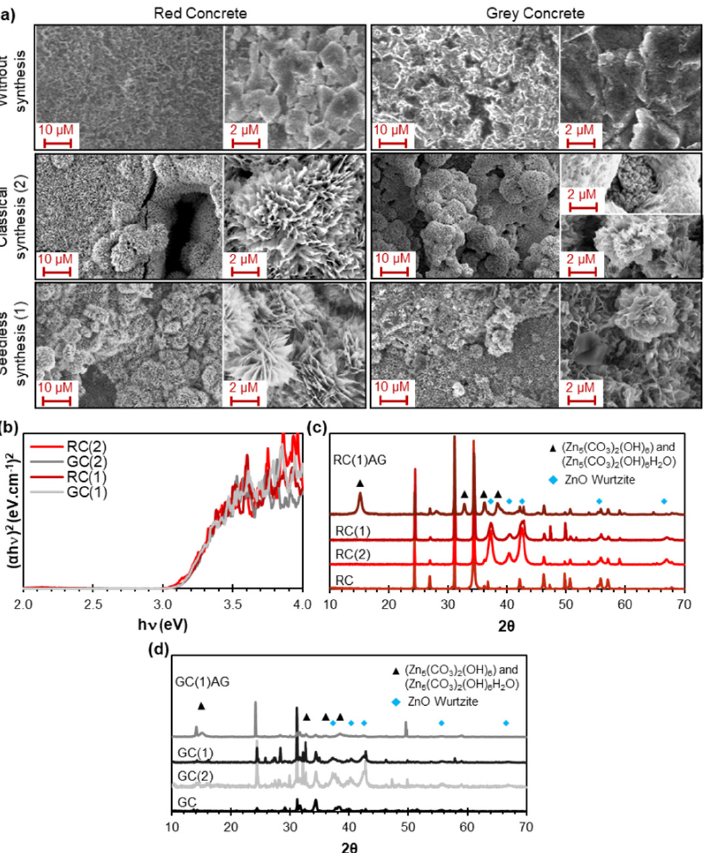
Figure 2. ( a ) SEM top-view pictures of bare concrete surfaces after 2 h of hydrothermal growth by the two-step hydrothermal method or the one-step seedless hydrothermal method; ( b ) UV-visible spectral plot with Tauc-Lorentz model of concrete surfaces after 2 h of hydrothermal growth by the two-step hydrothermal method or the one-step seedless hydrothermal method; ( c , d ) XRD pattern of concrete surfaces after 2 h of hydrothermal growth by the two-step hydrothermal method or the one-step seedless hydrothermal method.